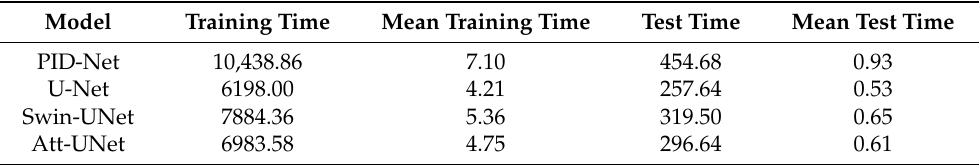
Table 6. The summary of computational time (in